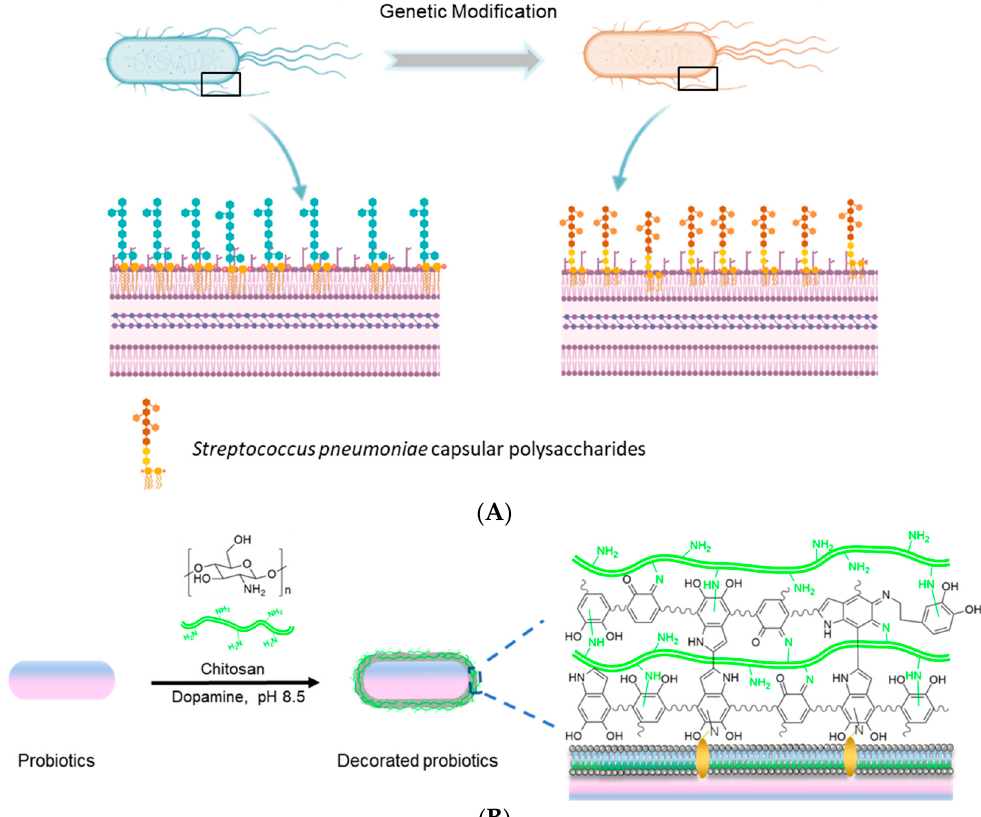
Figure 4. Engineered bacteria for oral delivery of therapeutic polysaccharides. ( A ) Oral delivery of Streptococcus pneumoniae capsular polysaccharides produced by recombinant attenuated Salmonella . Adapted from [82], published by National Academy of Sciences, 2021. ( B ) Attachment of chitosan on the surface of probiotics for enhanced oral delivery and biotherapy. Adapted with permission from [86]; published by Wiley-VCH, 2021.